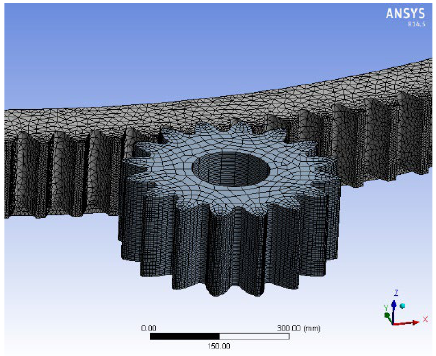
Figure 5. Meshing